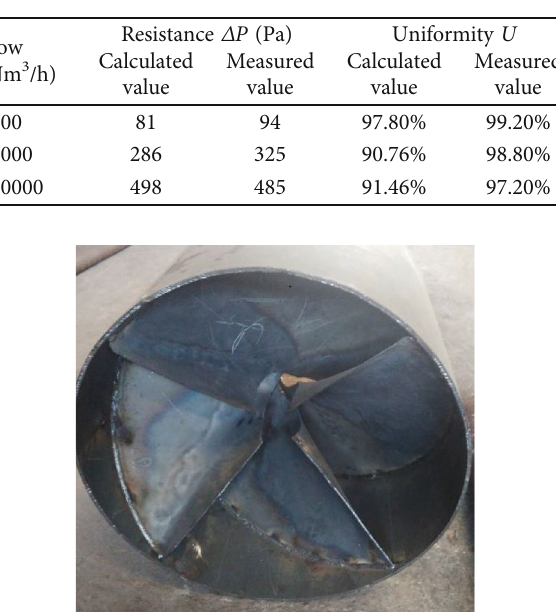
Table 2: Comparison between calculation and measured results of gas mixing unit.